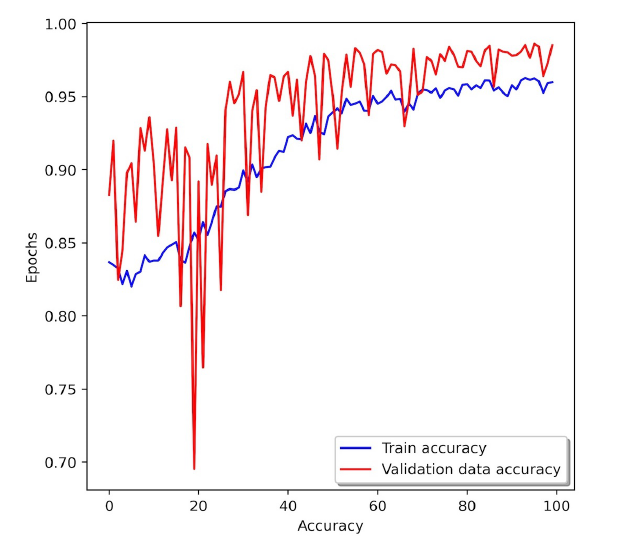
Figure 7. Evolution of accuracy in training DNN